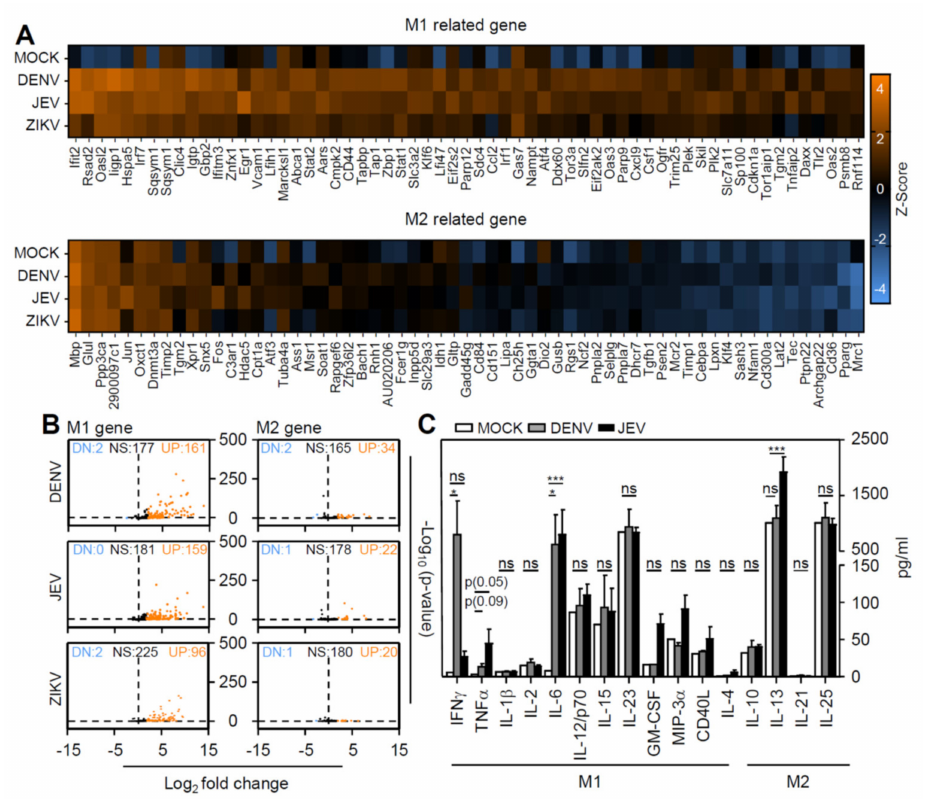
Figure 4. Flavivirus infection induced type 1 macrophage polarization and immune responses in the brain. In DENV-, JEV-, and ZIKV-infected brains, ( A ) representative heat map of the top 61 M1-related and M2-related gene expression. ( B ) The volcano plot showed the number of